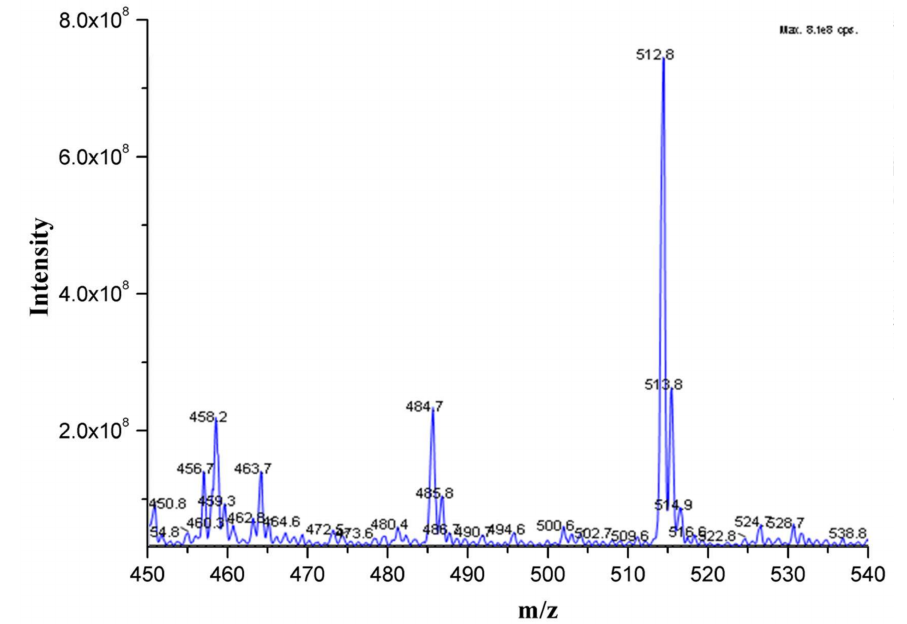
Figure 2. MS/MS spectra of FITC-Mel in negative-ion mode.